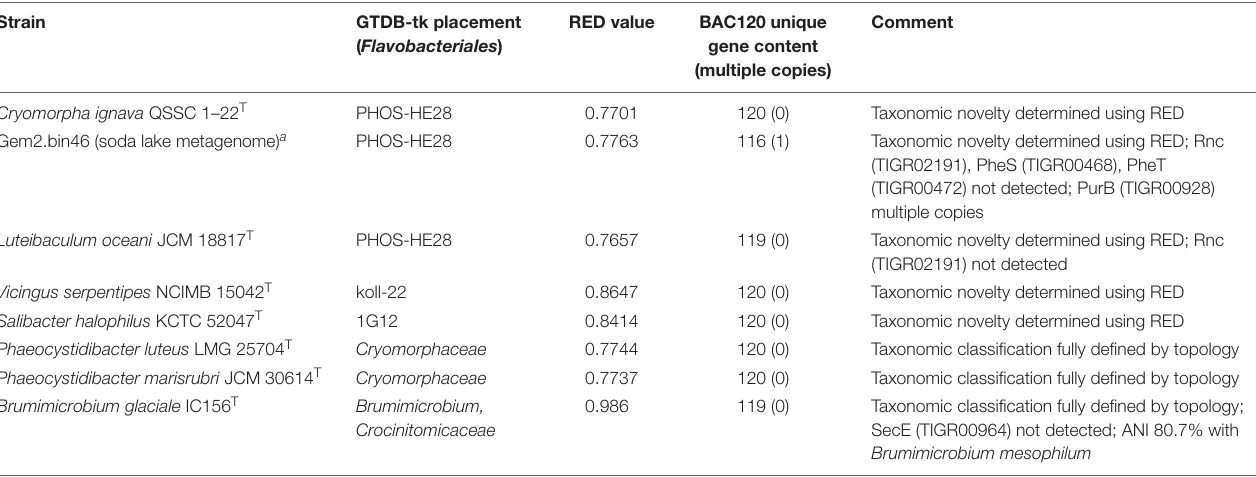
TABLE 1 | GTDB-tk (KBase) analysis of taxa investigated in this